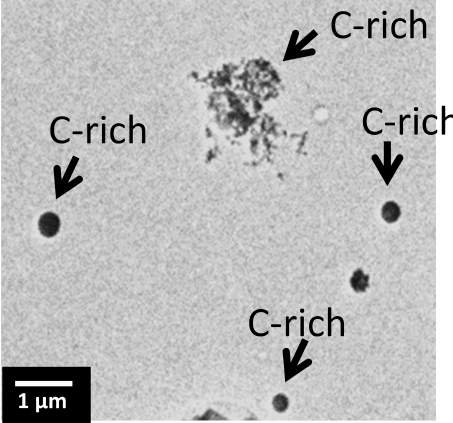
Figure 11. Photographs of an aerosol sample after passage through the TD at 400 ◦ C sampled for 10 min from 09:38 on 6 May